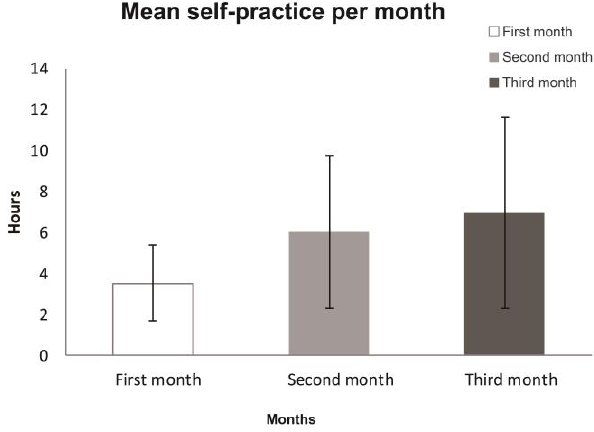
Figure 2. Mean self-practice hours per month of participants.